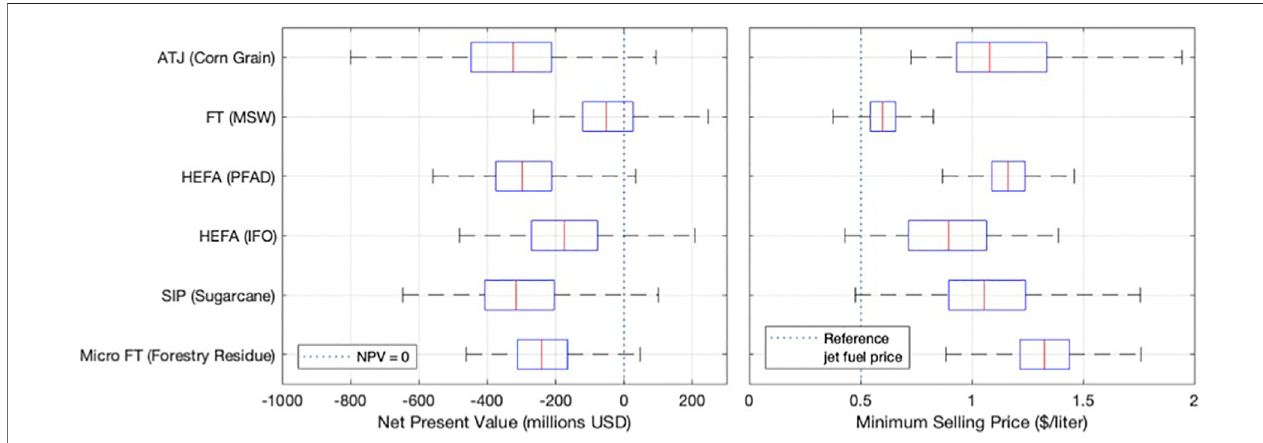
FIGURE1 | Box and whiskerplots of NPV and MSP values for all pathways with no policy added. Dotted linesindicate either anNPV ofzero, or the current market price of jet fuel (March 2019).